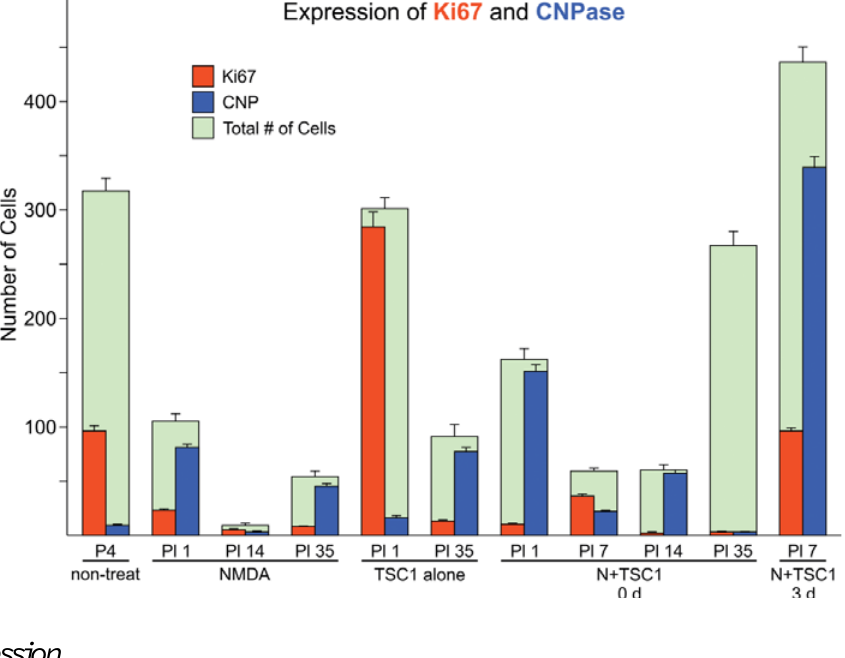
Figure 2. Cell loss in the subventricular zone (SVZ) is partially rescued in the presence of TSC1 via cell survival or cell proliferation. Double immunofluorescence: cells expressing the proliferation marker Ki67 were found in this region at early time points in the presence of TSC1. Some cells co-expressed the two markers (Ki67/CNPase). In contrast, when N -methyl- D -aspartate (NMDA) was injected alone there was a dramatic reduction of the total number of cells. Green bars represent the total number of cells ( i.e. , 100% or the total number of cells counted in that field. Numbers for saline and non-treated mice were very close with no significant differences. Values are expressed as mean ± SEM of the counts of 9 fields per area from three independent experiments. p < 0.05 vs. controls. All differences with respect to non-treated mouse brains as well as, across treatments were significant. P5 = Postnatal day five; PI = post injection